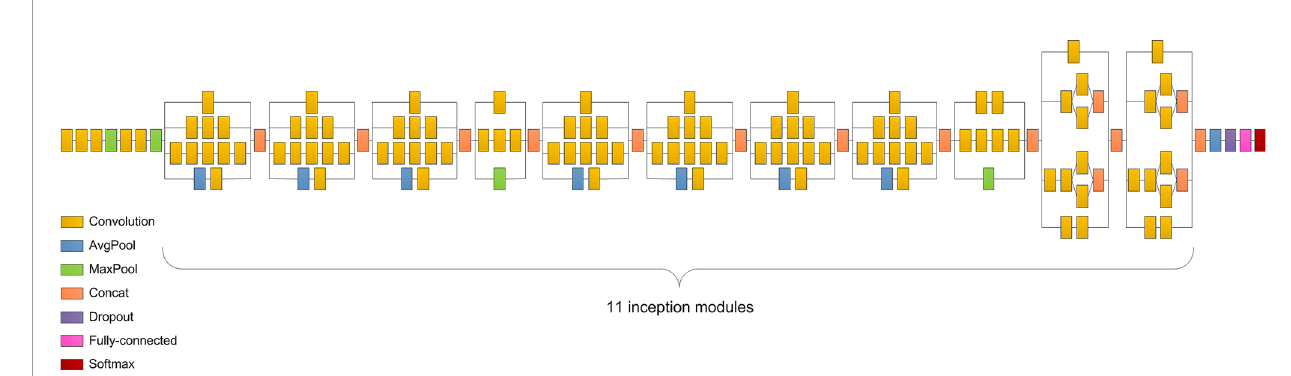
FIGURE 4 | Inception v3 consists of fi ve convolutional layers, two max-pooling layers, 11 inception modules, one average pooling layer, and one fully connected